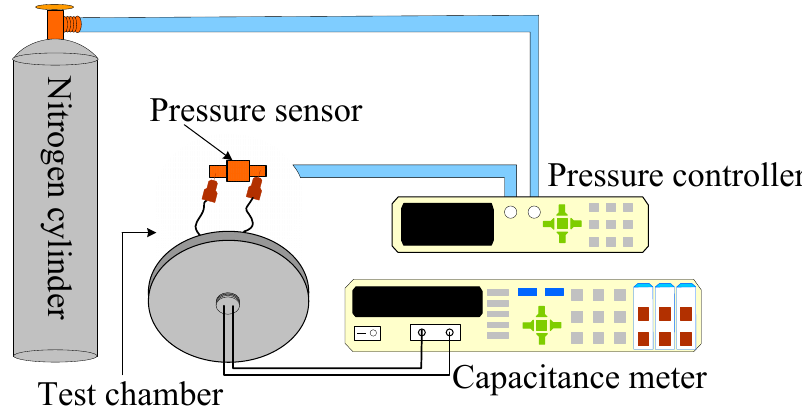
Figure 3. Experimental setup. The sensor was mounted in the pressure chamber. The applied force and capacitance change were measured by the pressure controller and capacitance meter, respectively.